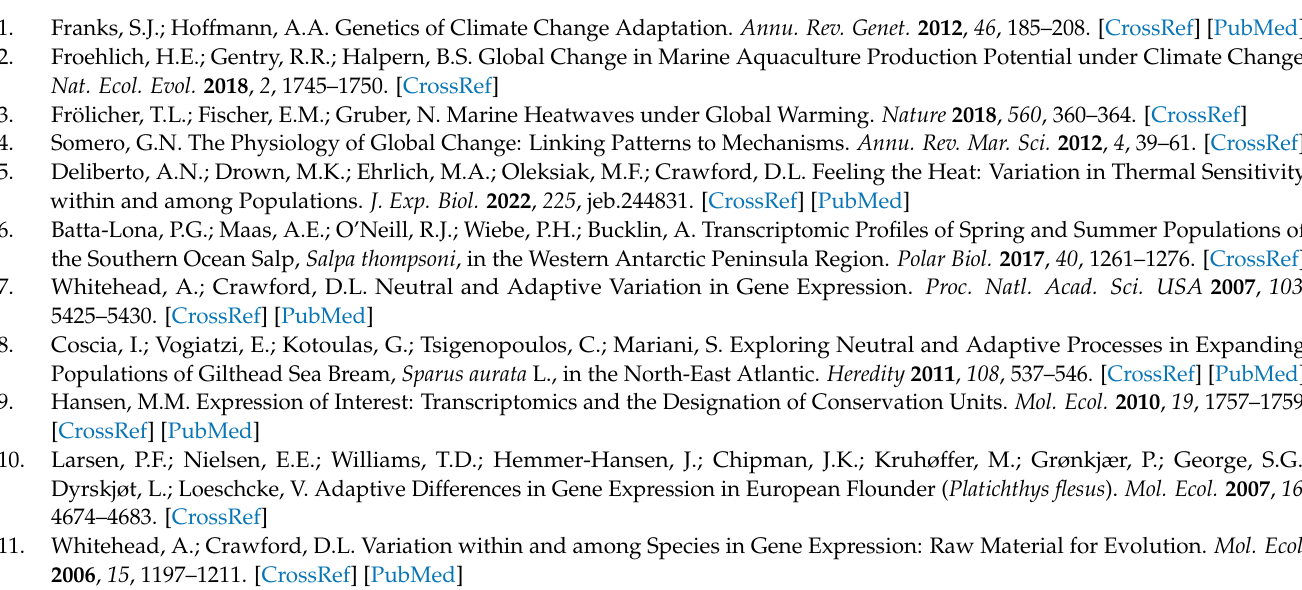
Figure S3: Heatmap showing gene expression variation across samples for the 105 genes which were significant for the Race factor in the 2-way ANOVA and contributed to the associated enriched GO terms, Figure S4: Heatmap showing gene expression variation across samples for the genes which were significant for Latitude only in the 2-way ANOVA and contributed to the enriched GO terms, Figure S5: Average expression in populations for the 9 genes which were significant for Race × Latitude interaction in the 2-way ANOVA.). Supplementary Results (csv